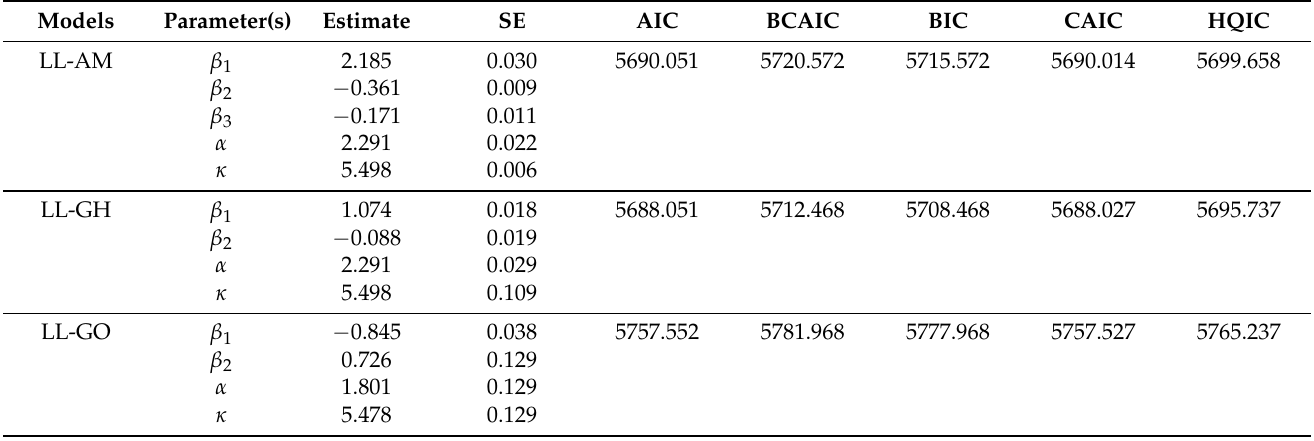
Table 3. Results from the fitted proposed fully-parametric odds-based and hazard-based regression models with LL baseline distribution to IPASS